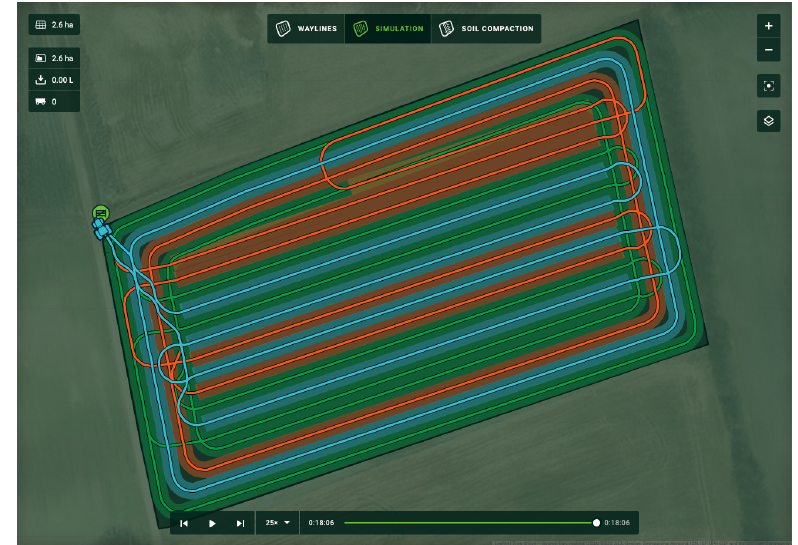
Figure 7. Route plan for a ripper operation with three